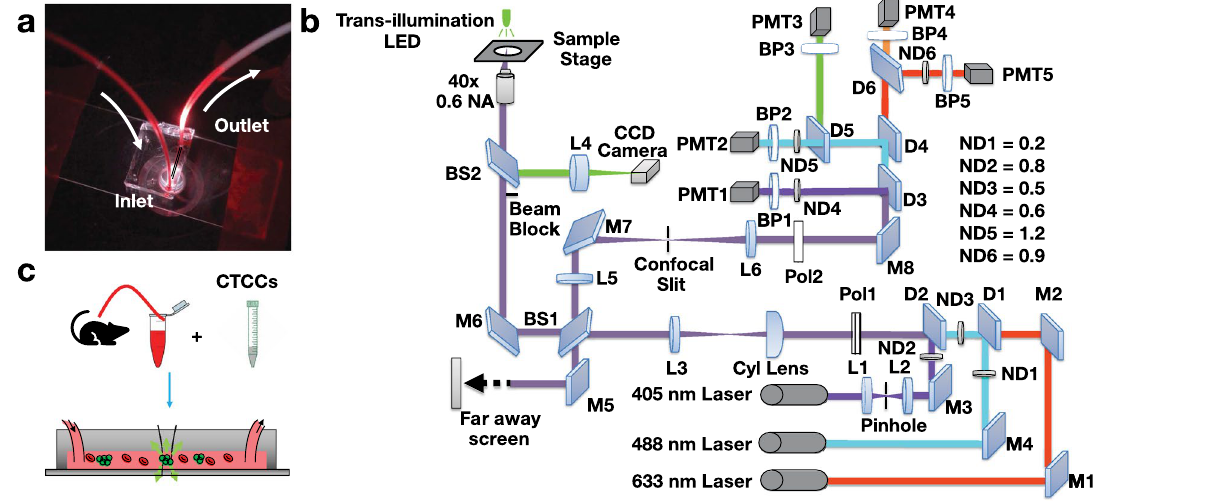
Figure 1. ( a ) Microfluidic device. ( b ) Flow cytometer schematic. D dichroic, L lens, M mirror, BP bandpass filter, BS beam splitter, PMT photomultiplier tube, Pol polarizer, CAM CCD camera, ND neutral density filter, Cyl Lens cylindrical lens. ( c ) Schematic of experimental design for detection of CTCCs in whole blood flowed through a 30 × 30 μm 2 microfluidic